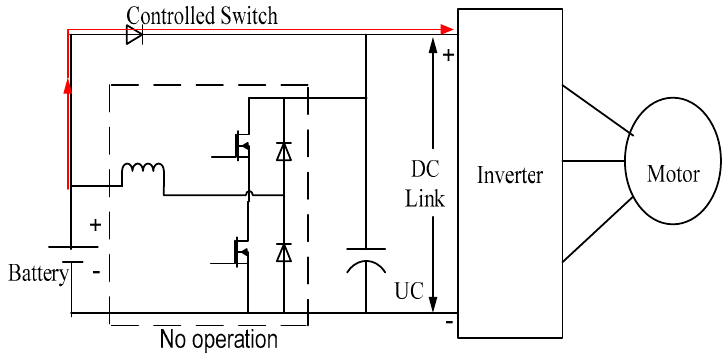
Figure 6. Fast constant-speed operation.